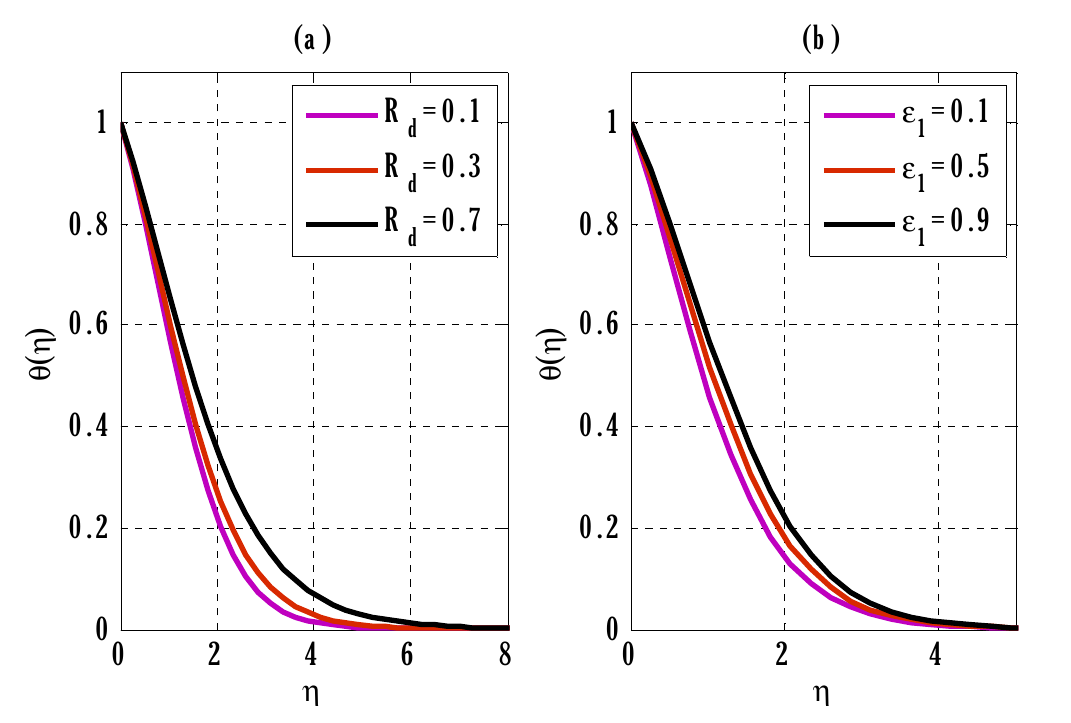
Figure 5. Variation of radiation parameter and a small parameter (in thermal conductivity) on temperature profile using β = 3, M = 0.1, λ = 0.1, F r = 0.1, N t = 0.1, S c = 1.5, N b = 0.1, E c = 0.4, E 1 = 0.01, ε 2 = 0.5, P r = 1.7, γ = 0.1. ( a ) ε 1 = 0.9 ( b ) R d = 0.1.